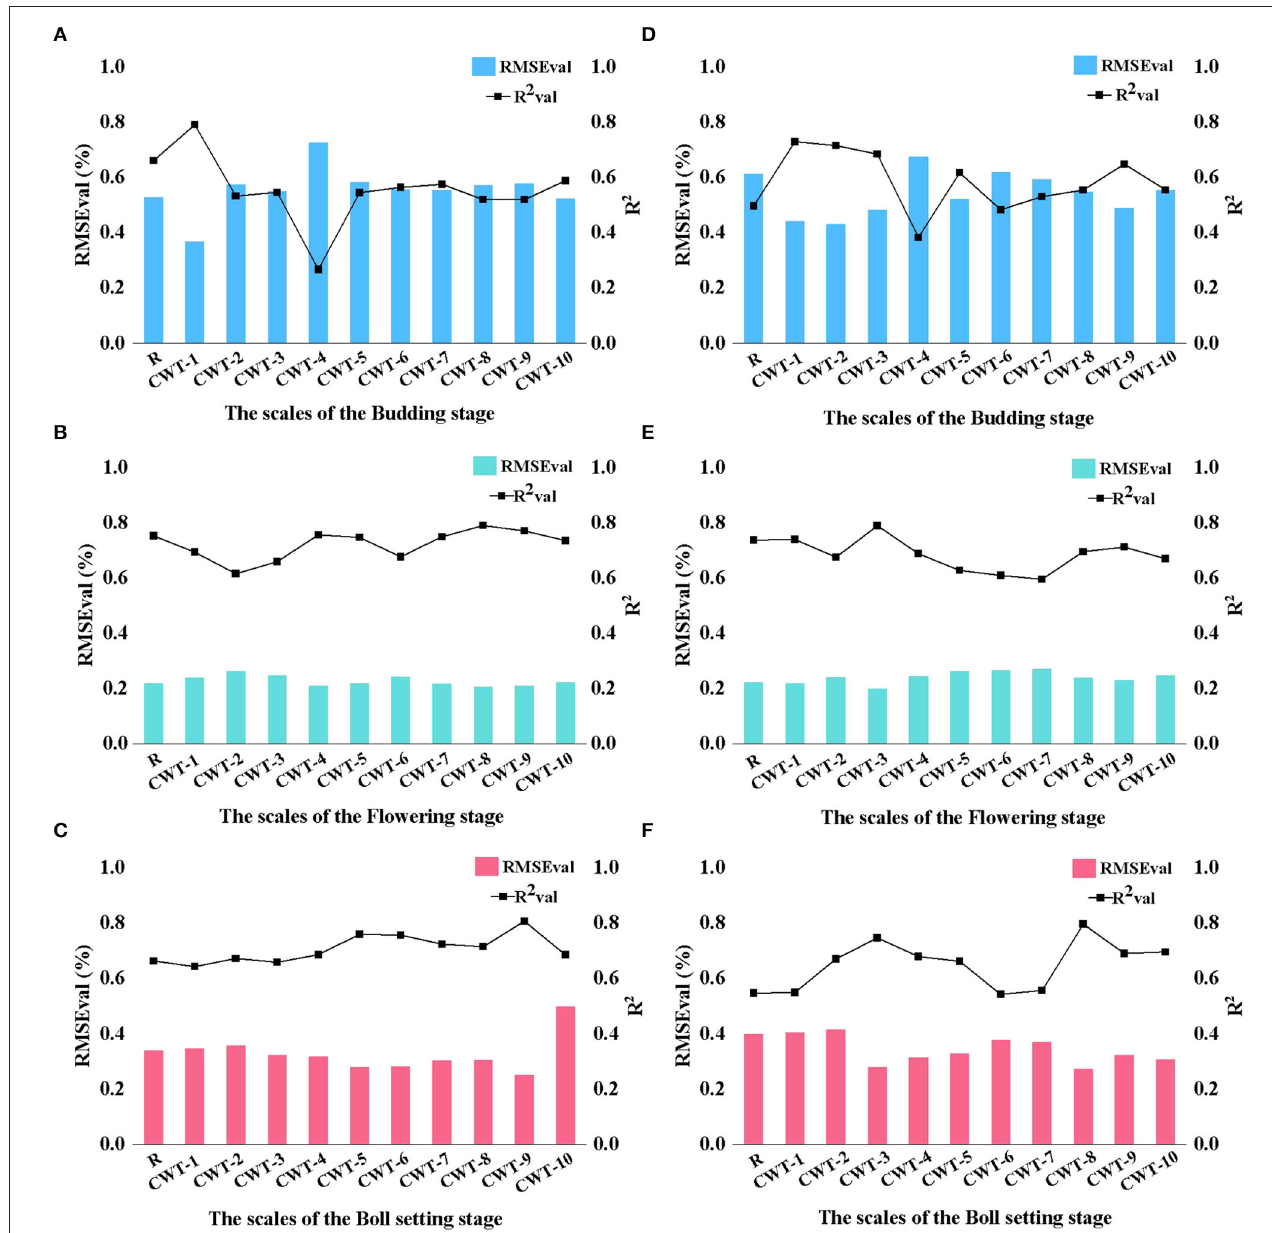
FIGURE 7 | PLSR estimation model of the LKC in cotton based on R and CWT spectra (validation sets). (A) CARS-Budding stage. (B) CARS-Flowering stage. (C) CARS-Boll setting stage. (D) RF-Budding stage. (E) RF-Flowering stage. (F) RF-Boll setting stage.